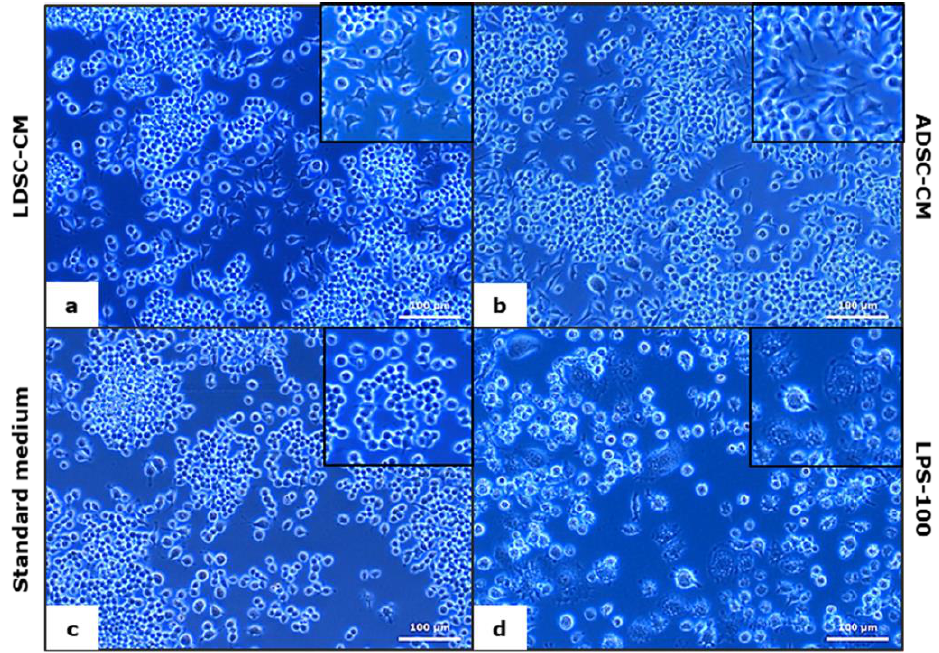
Figure 4. Morphology of RAW 264.7 macrophages cultured for 48 h in LDSC-CM ( a ), ADSC-CM ( b ), standard medium ( c ) and LPS-100 ( d ); phase contrast with objective magnification 20×.